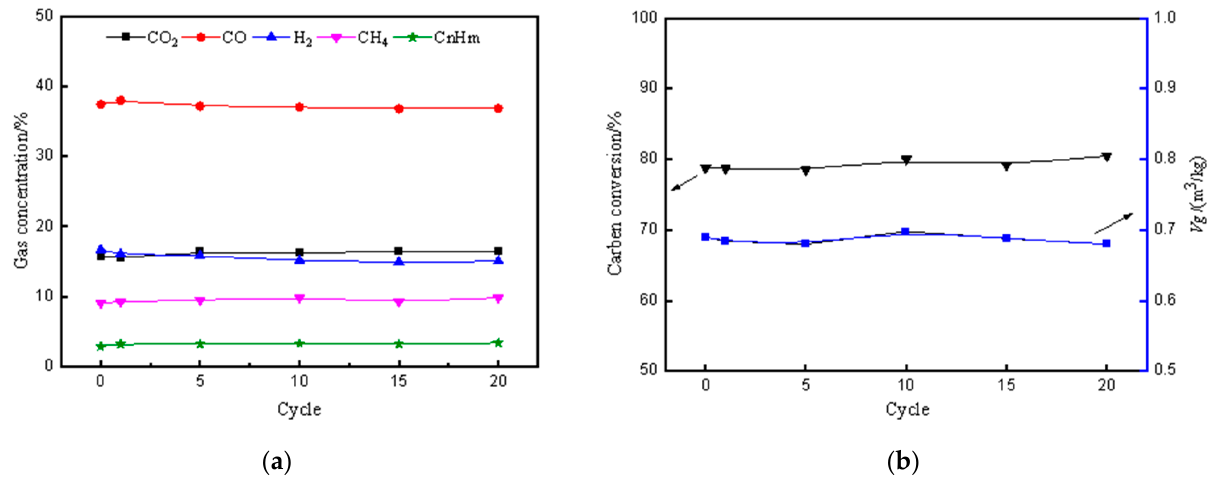
Figure 8. The effect of repeated GLC cycles upon ( a ) the gas concentrations and ( b ) the carbon conversion (black line, left-hand axis) and valid gas yield (blue line, right-hand axis) during wood waste gasification.